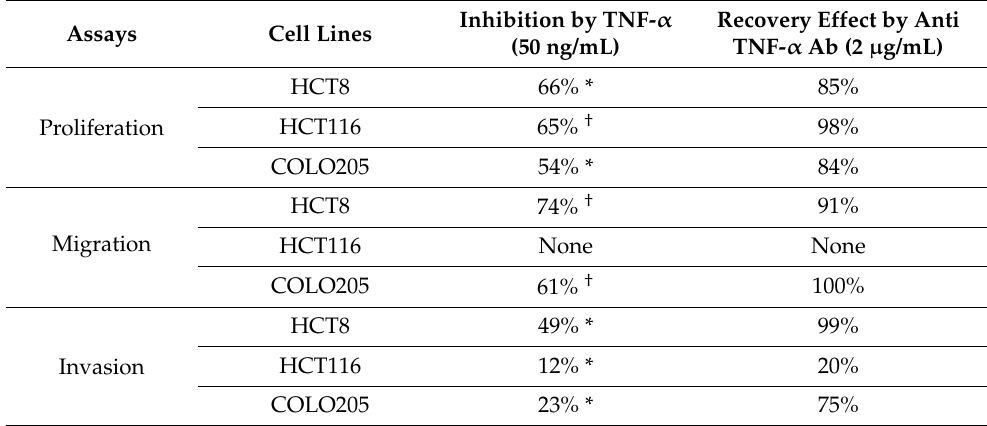
Table 1. Summary of proliferation, migration, and invasion assays of colon cancer cell lines incubated with TNF- α and anti TNF- α